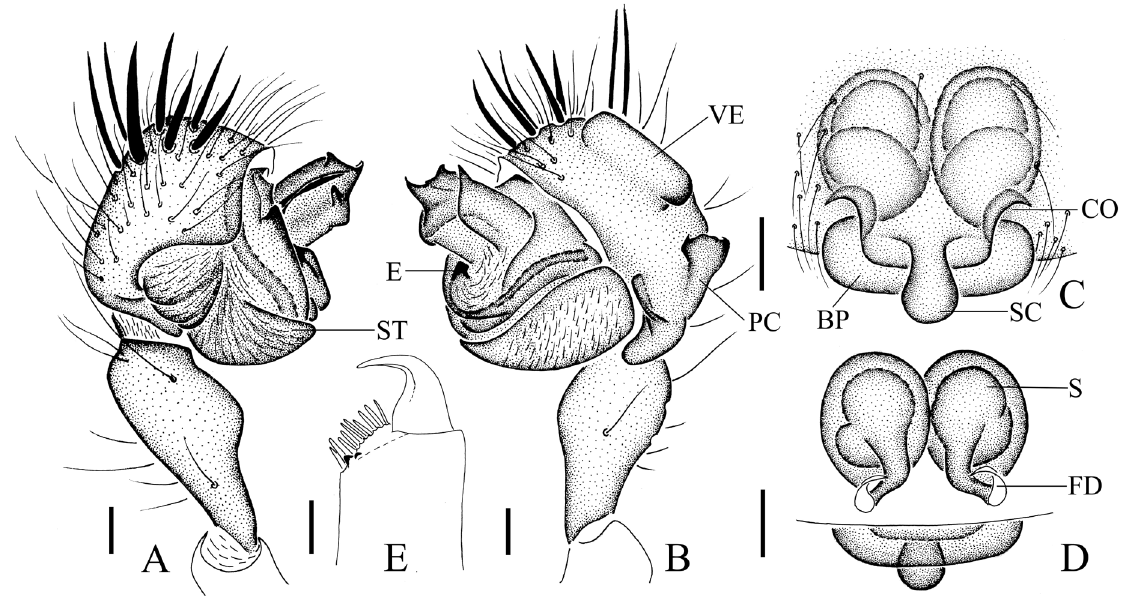
Fig. 5. Mimetus yinae sp. nov. A – B , E . Holotype, ♂ (GZ-MIM-2015-005). C – D . Paratype, ♀ (GZ- MIM-2017-001). A . Palp, prolateral view. B . Palp, retrolateral view. C . Epigyne, ventral view. D . Vulva, dorsal view. E . Left chelicerae, ventral view. Scale bars = 0.1